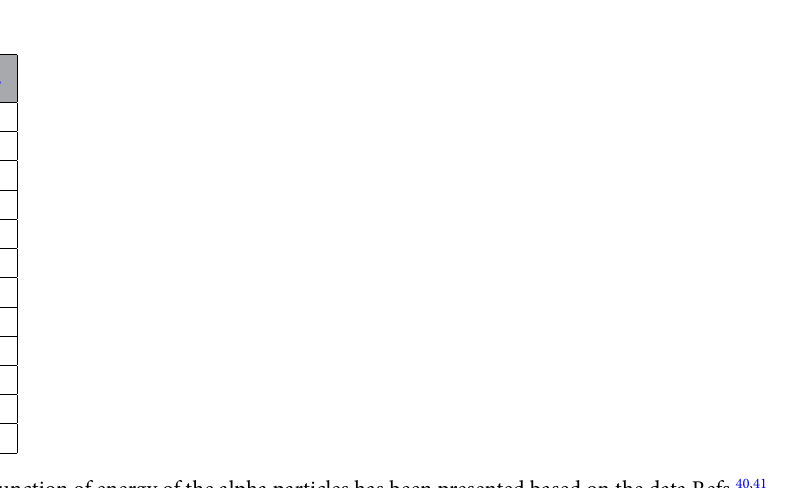
Table 2. The LET as a function of energy of the alpha particles has been presented based on the data Refs. 40,41 . Also, the RBE as a function of the LET has been presented in this table according to Ref. 43 for 10% surviving